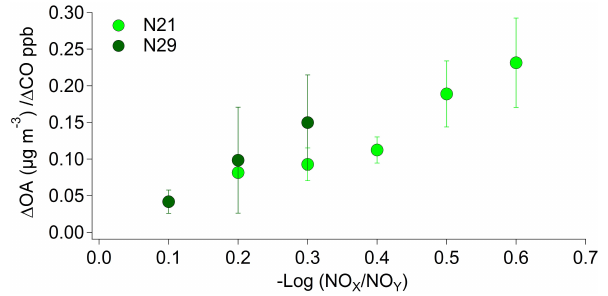
Fig. 7. The change in the 1 OA/ 1 CO for N21 and for N29 as a function of photochemical